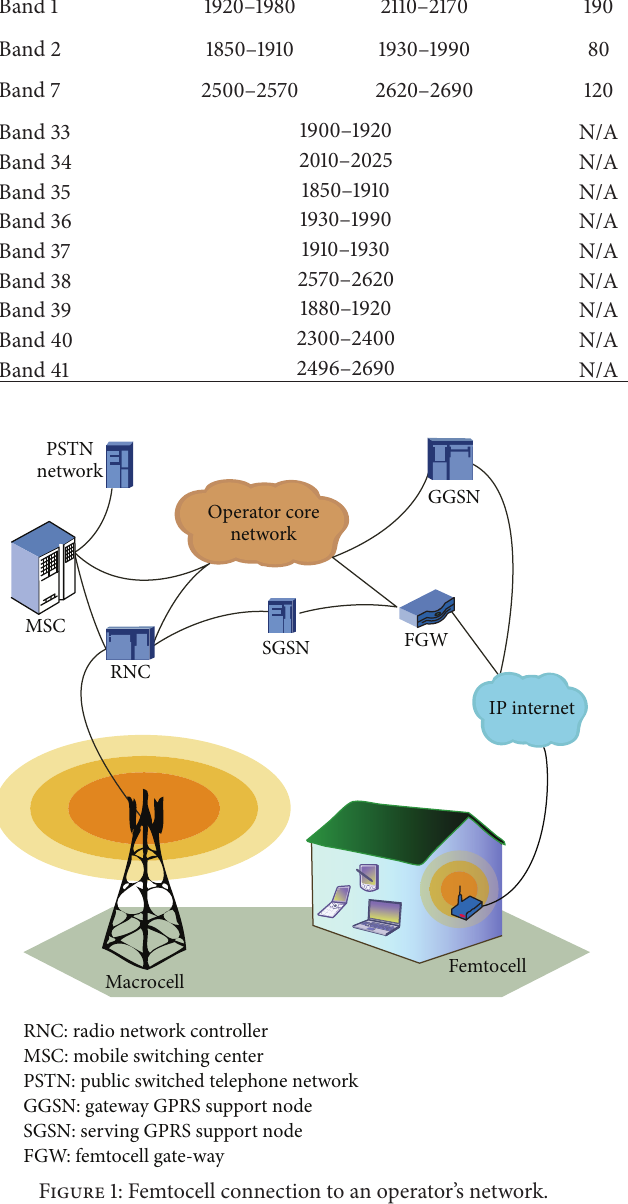
Figure 1: Femtocell connection to an operator’s